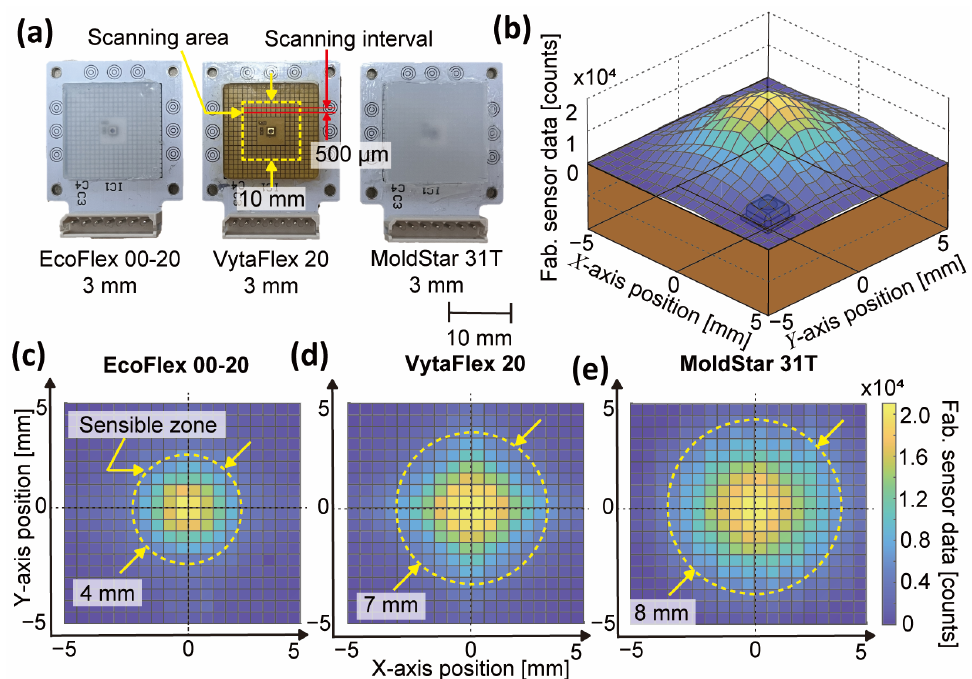
Figure 4. Experimental results of investigating sensible zone. ( a ) Picture of samples with scanning area and interval. ( b ) Sensing result in 3D of VytaFlex sample, showing sensing point close to the sensing hole reacts sensitively. ( c − e ) Sensing results in 2D where bigger shore hardness material has a wider sensible zone.